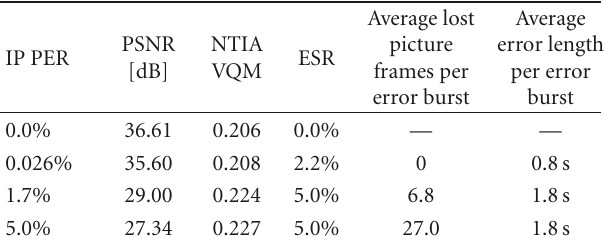
Table 5: Video quality measurement results at MFER 5% at di ff erent IP packet error